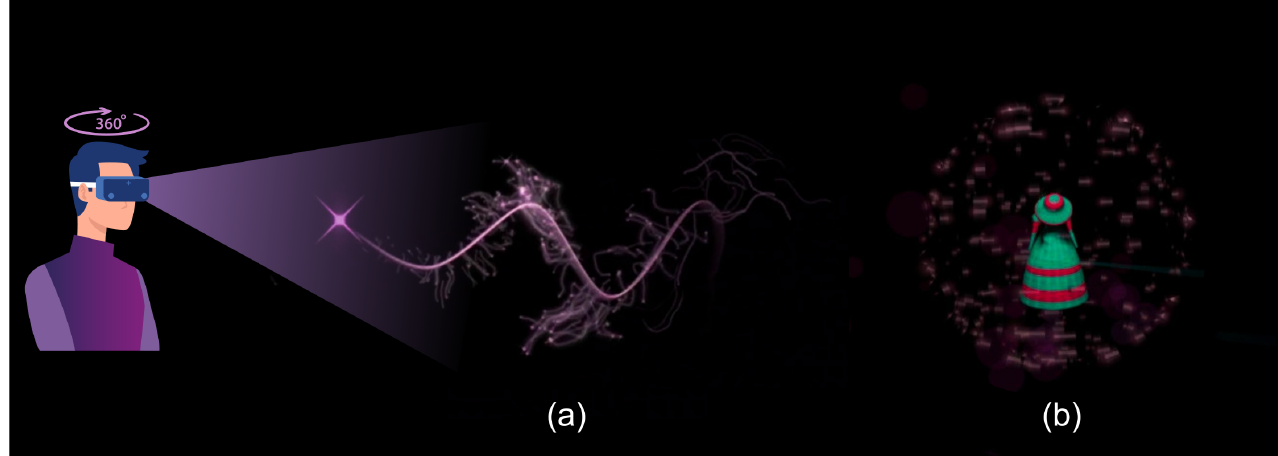
Figure 3. Introduction scene: ( a ) Orb that appears with purple particles that spark in front of the user. The orb moves to the next position once the user points at the orb with the controller and presses an action button. ( b ) Introduction of Maulina after the movement of the orb through different